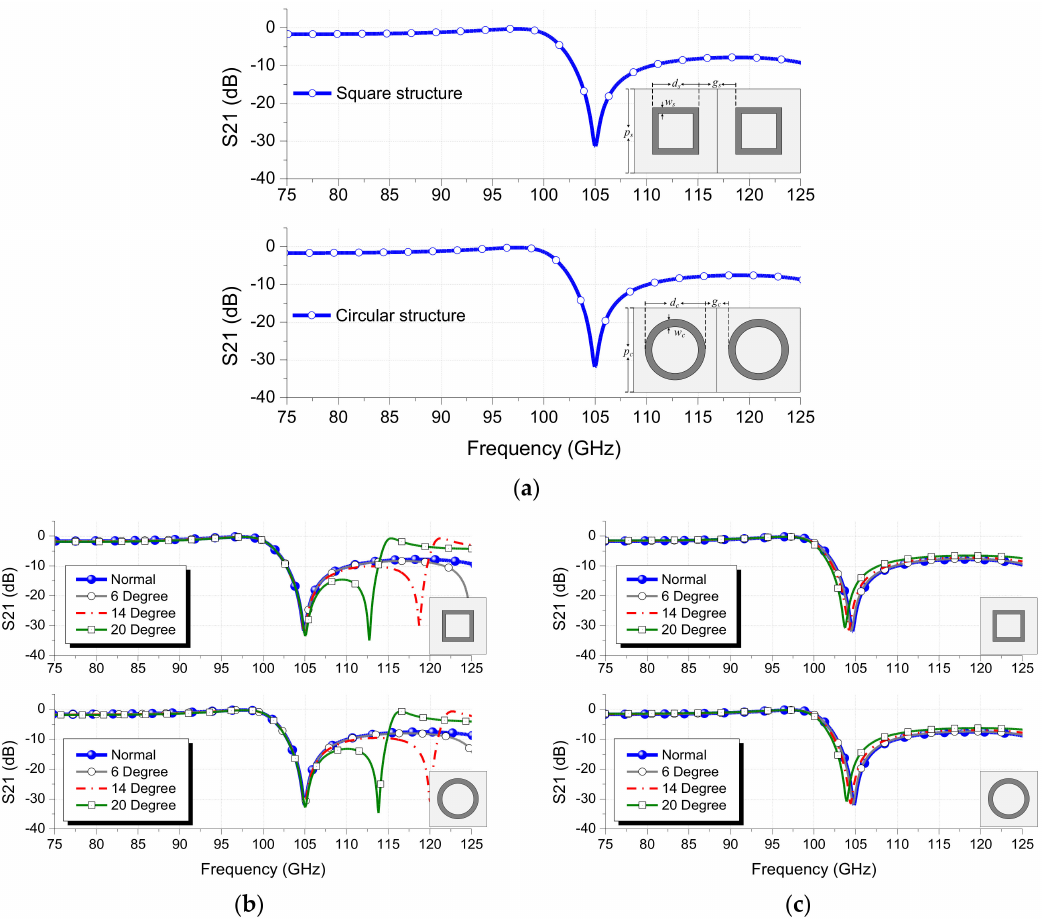
Figure 4. Frequency responses of square-loop and circular-loop FSSs: ( a ) normal incidence, ( b ) TE excitation, ( c ) TM